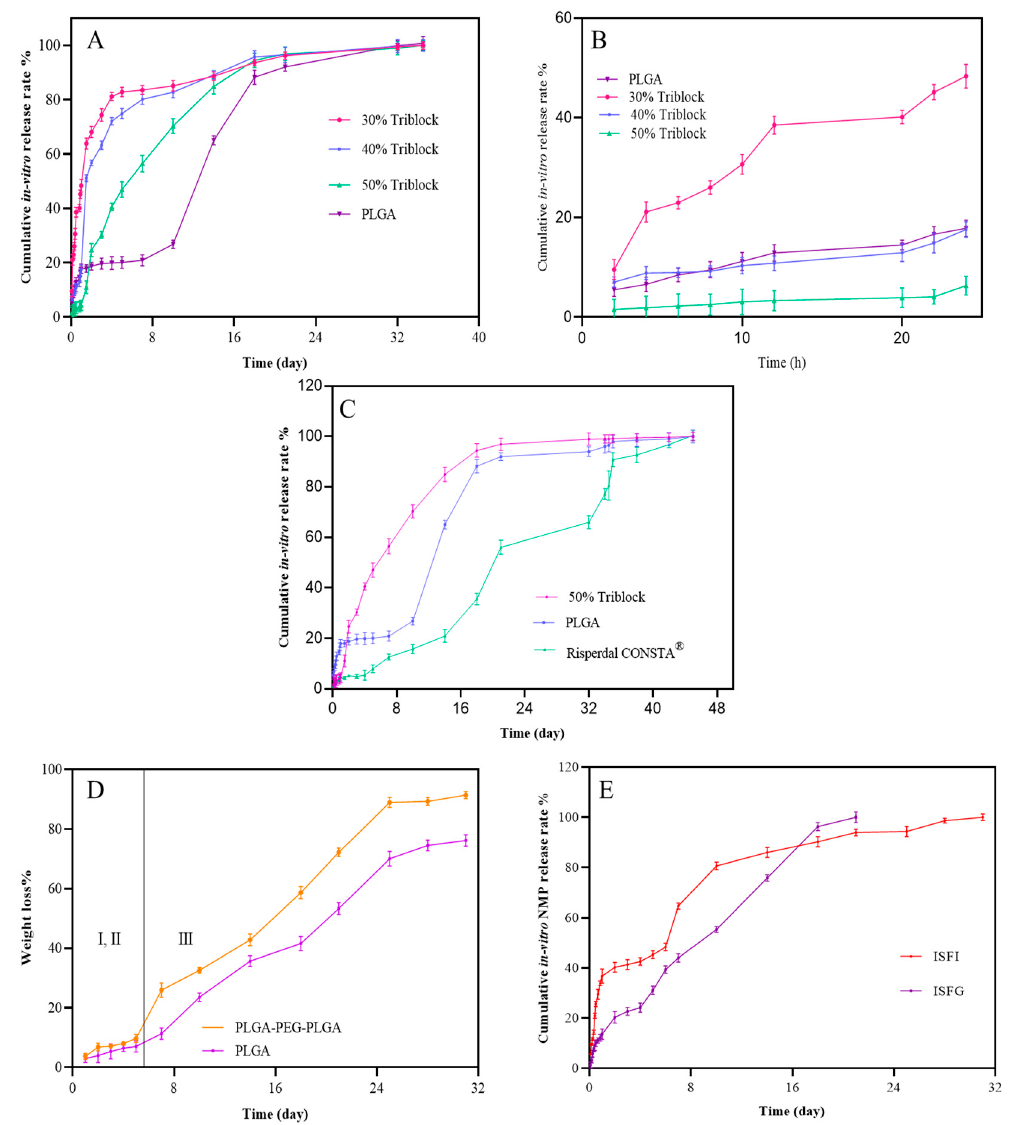
Figure 3. Cumulative in-vitro release percentage of risperidone from ISFG (30, 40, and 50%) and ISFI formulations ( A ), initial in-vitro release percentage ( B ), cumulative in-vitro release percentage of risperidone from optimal tri-block (50%), PLGA, and Risperdal CONSTA ® ( C ). In vitro degradation of ISFI and ISFG ( D ) Comparison of the percentage of the cumulative release of NMP from ISFI and ISFG formulations (E).